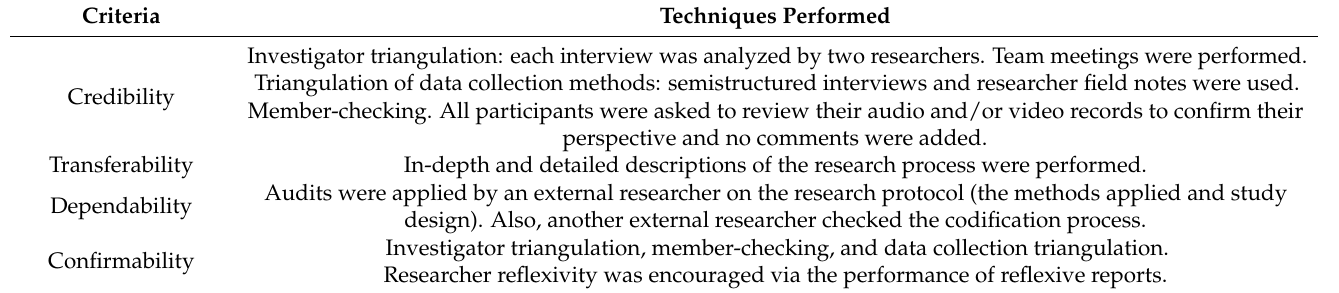
Table 2. Criteria used to control